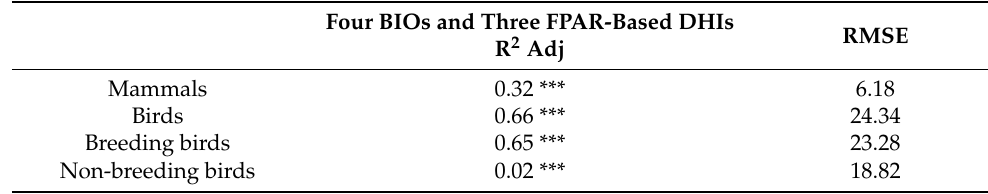
Figure 8. Pairs of the Spearman correlations of all MODIS FPAR-based DHIs and the four Bioclim variables (BIO12, BIO14, BIO17 and BIO19) versus the species richness of the four taxa (mammals, birds, breeding birds and non-breeding birds). Significant relations: *** p < 0.001.